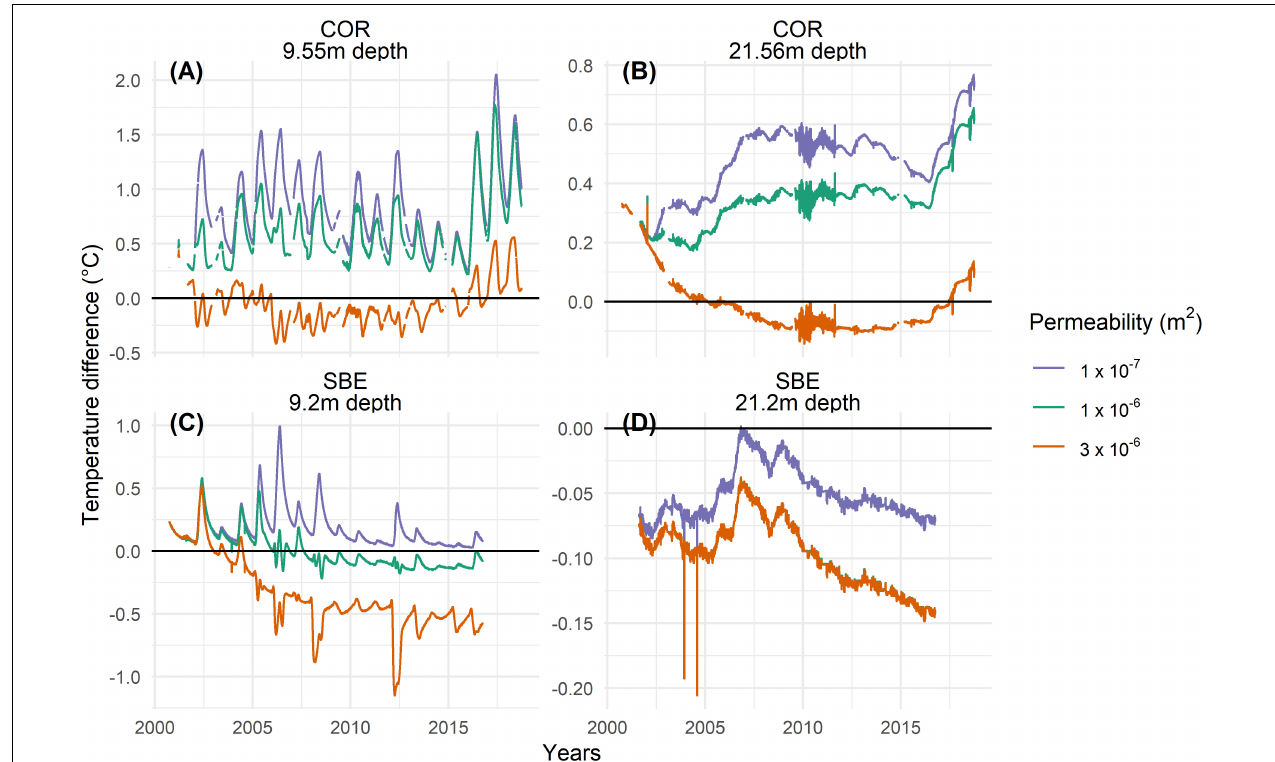
FIGURE 5 | Temperature difference (observed minus modeled) at two different depths of approximately 10 m (A,C) and 20 m (B,D) for COR (A,B) and SBE (C,D) . The black zero-line indicates a perfect match with the measured temperature at the borehole COR0287 and SBE0290 respectively. The color lines represent the difference from the modeled to the measured temperatures for different permeability values. In panel (D) the orange line covers the green line.